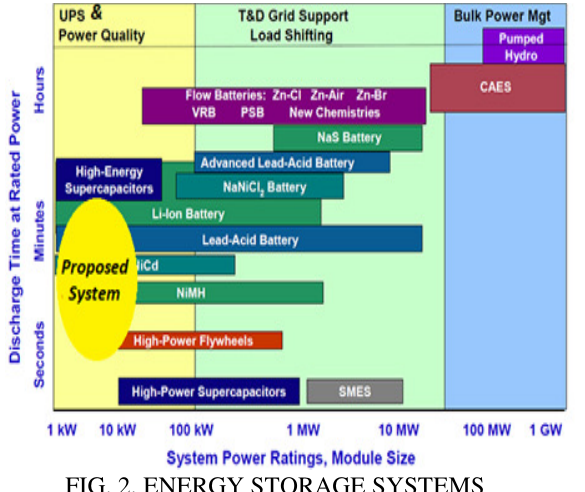
FIG. 2. ENERGY STORAGE SYSTEMS APPLICATION RANGE